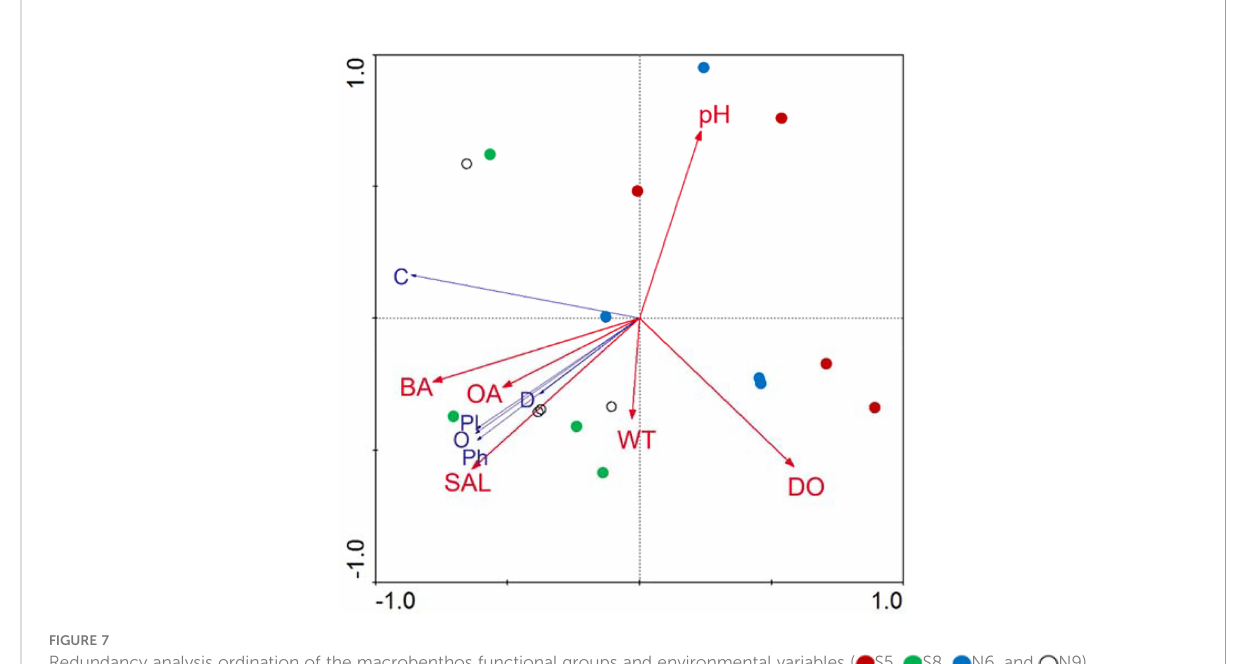
FIGURE 7 Redundancy analysis ordination of the macrobenthos functional groups and environmental variables ( S5, S8, N6, and N9). DO, dissolved oxygen; WT, water temperature; SAL, water salinity; BA, barnacle abundance; and OA, oyster abundance.